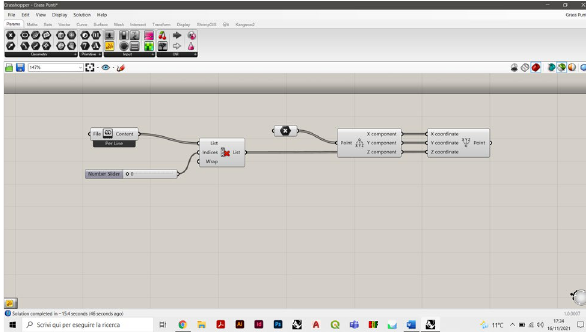
Figure 1 : import of the 3 coordinates of each point of the park into Grasshopper environment.